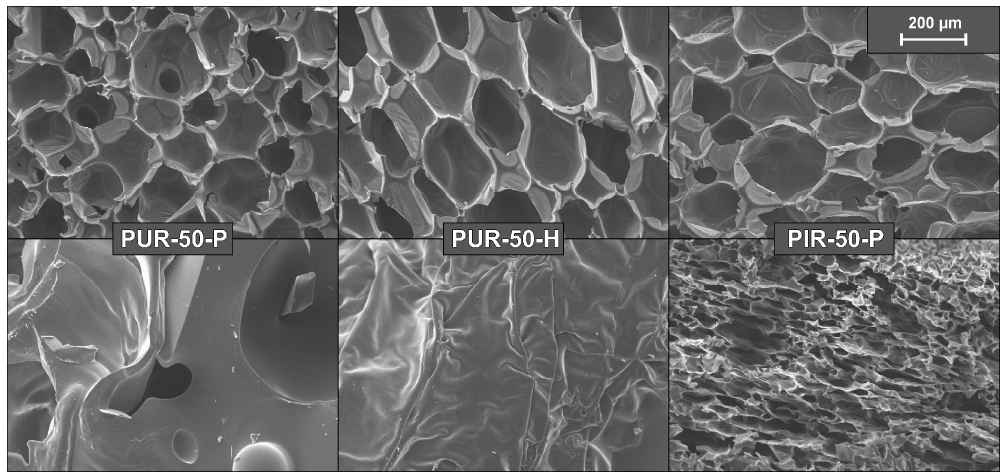
Figure 14. SEM micrographs of the structure of PUR-50-P, PUR-50-H, and PIR-50-P foam and residue.